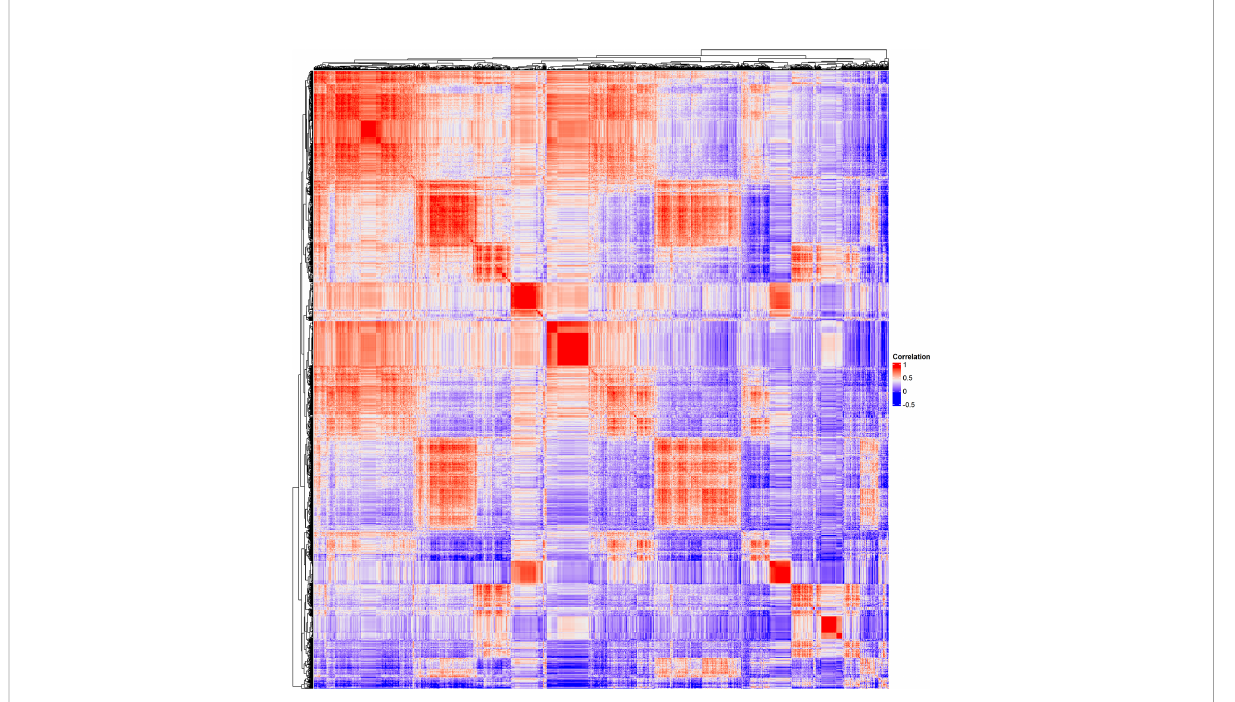
FIGURE 2 Correlation heatmap of genes of HPyVs and human genes with CUB similar to that of